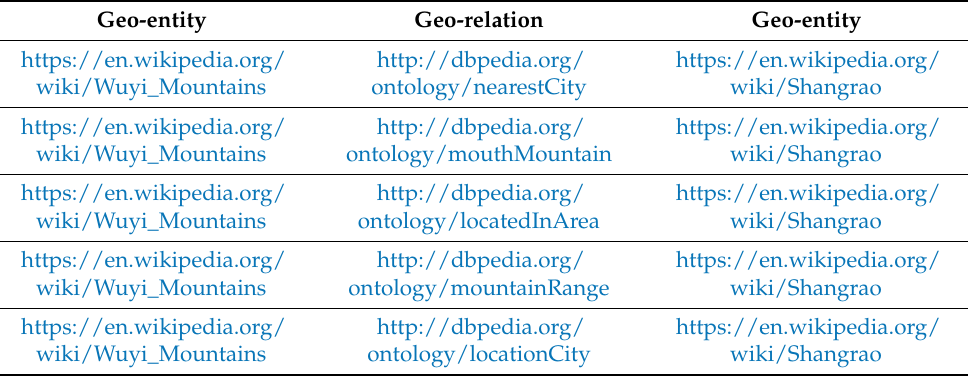
Table 8. The top 5 in Geo-relation prediction case. (all website are accessed on 14 September